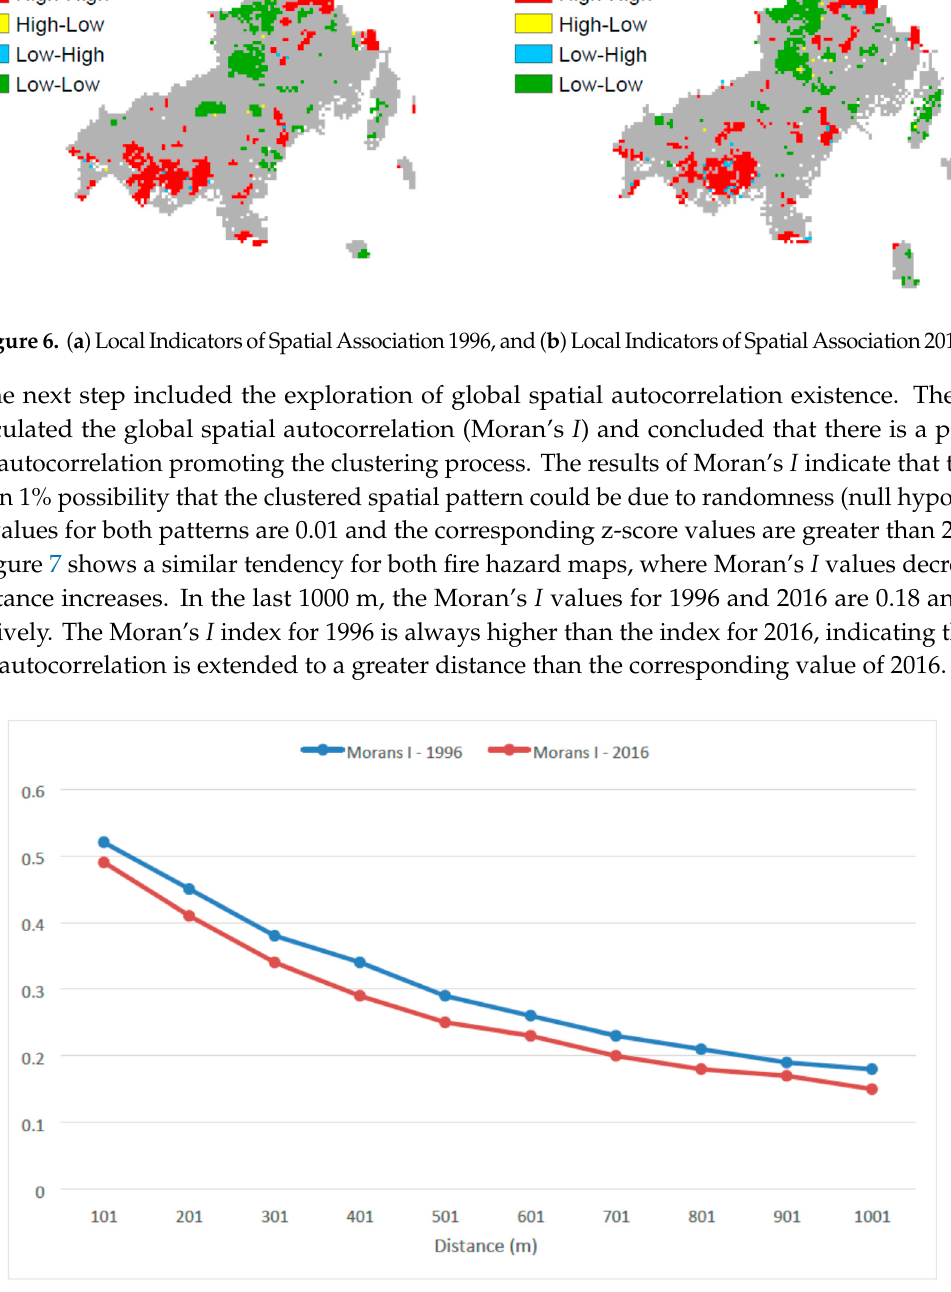
Figure 7. Moran’s I index for fire hazard (1996 and 2016) in relation to distance.